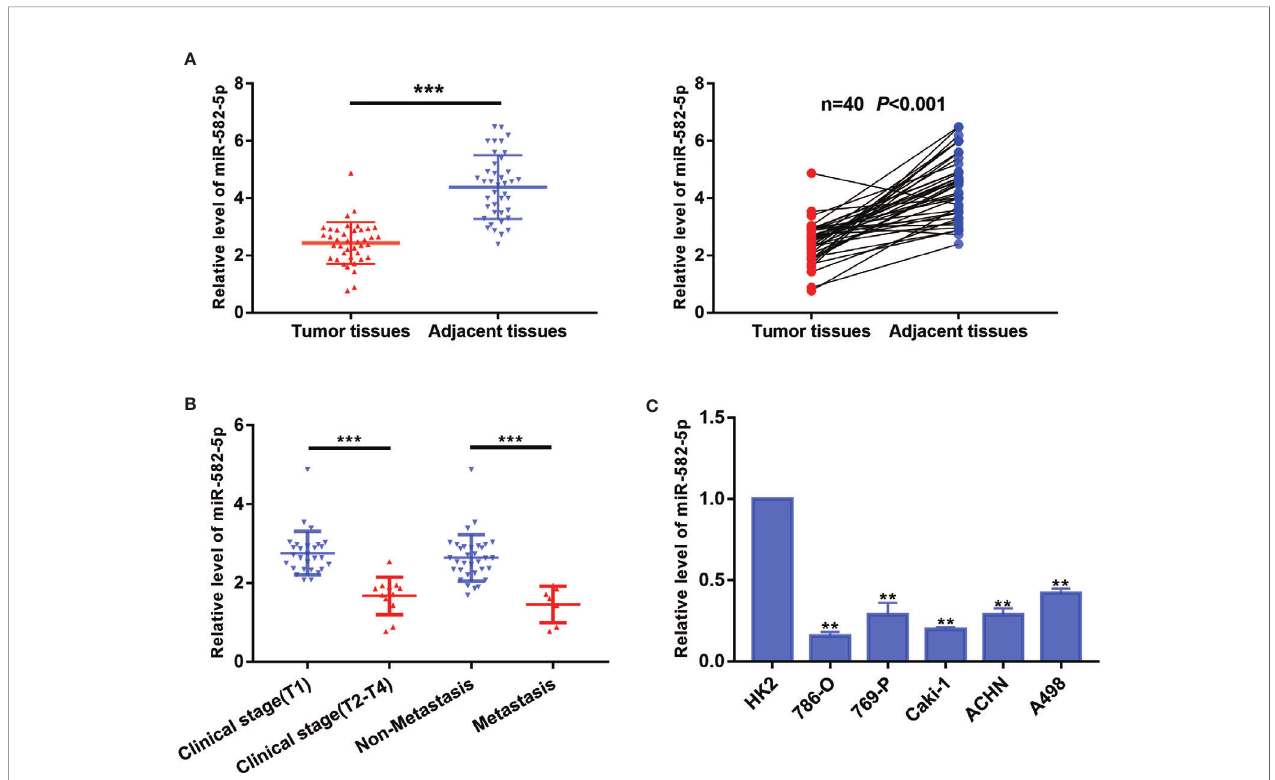
FIGURE 1 | MiR-582-5p was downregulation in ccRCC tissues and cell lines. (A) miR-582-5p level in 40 ccRCC tissues and paired adjacent tissues was investigated by qRT-PCR. (B) Relative expression of miR-582-5p were determined by qRT-PCR in different clinical stage of ccRCC tissues. (C) miR-582-5p level in human normal renal tubular epithelial cell line HK-2 and fi ve ccRCC cell lines was investigated by qRT-PCR; U6 was used as an internal control. The data are shown as the mean ± SD (** P < 0.01; *** P < 0.001). The experiments were repeated three times with similar